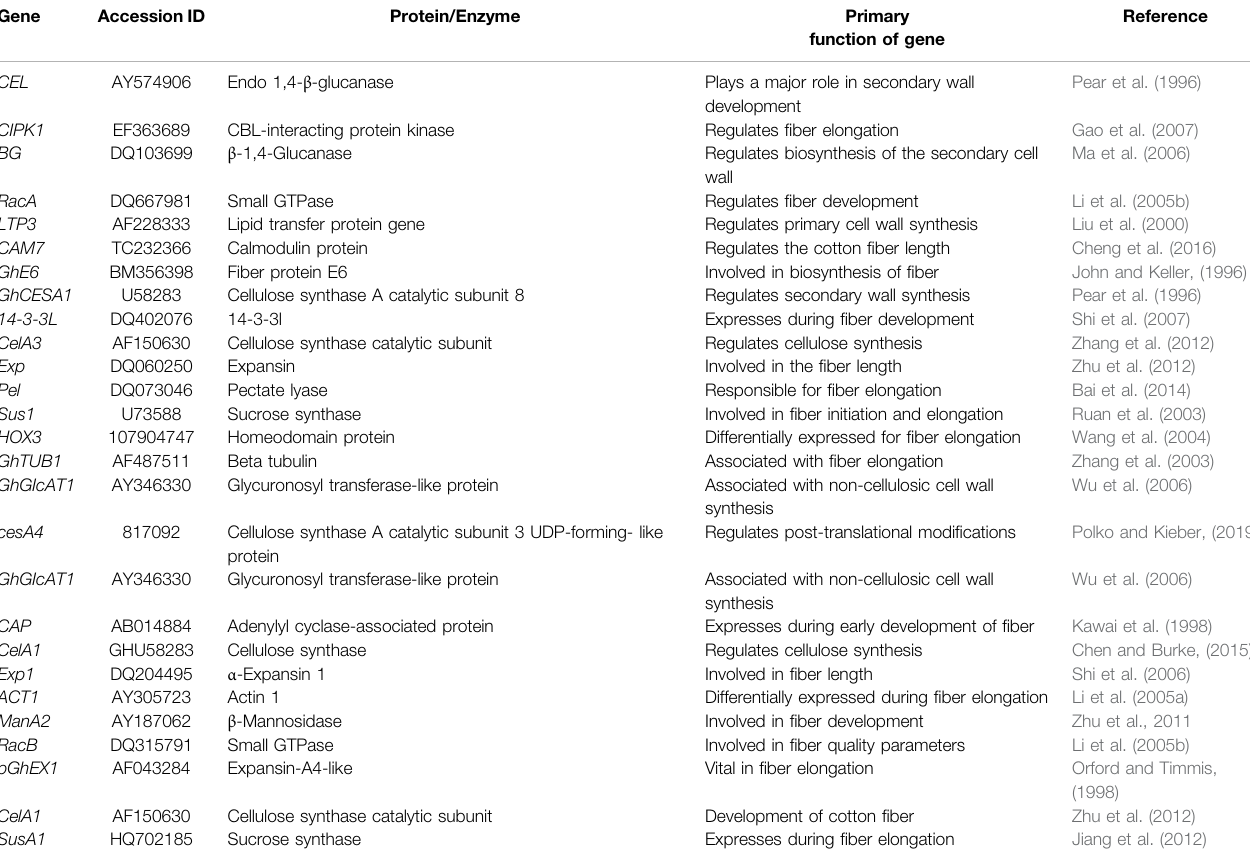
TABLE 1 | Major genes for fi ber development across the whole genome of G. hirsutum